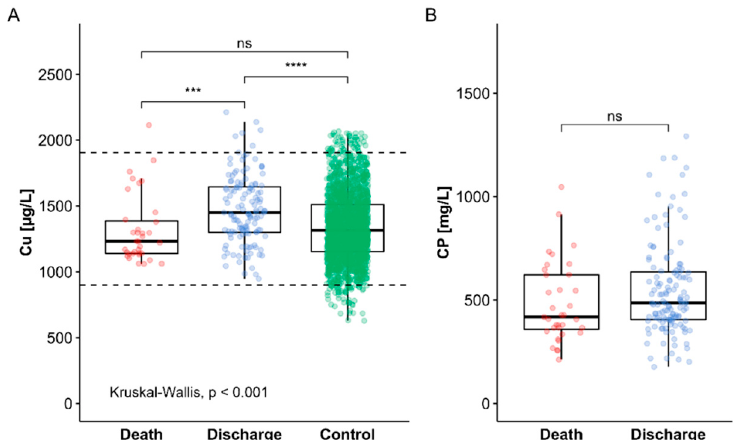
Figure 2. Elevated serum Cu status in patients surviving COVID-19. Serum samples from surviving and non-surviving COVID-19 patients were analysed for two biomarkers of Cu status, i.e., total serum Cu and CP concentrations. ( A ) Samples from COVID-19 survivors displayed significantly elevated serum Cu in comparison to non-survivors and to a reference cohort of healthy adult subjects. ( B ) Circulating levels of the Cu transport protein CP were slightly but not significant elevated in surviving as compared to non-surviving patients. Comparisons between two groups by Mann- Whitney U test, and among the groups by Kruskal–Wallis test; *** p < 0.001 and **** p < 0.0001.